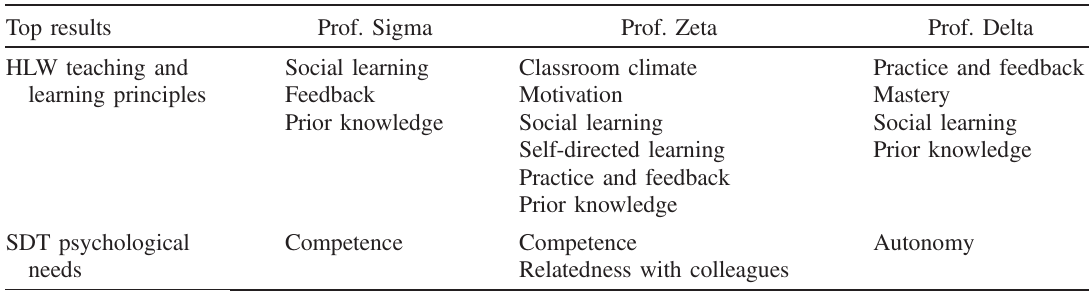
TABLE IV. Teaching and learning principles from HLW and psychological needs from SDT emphasized by each case study